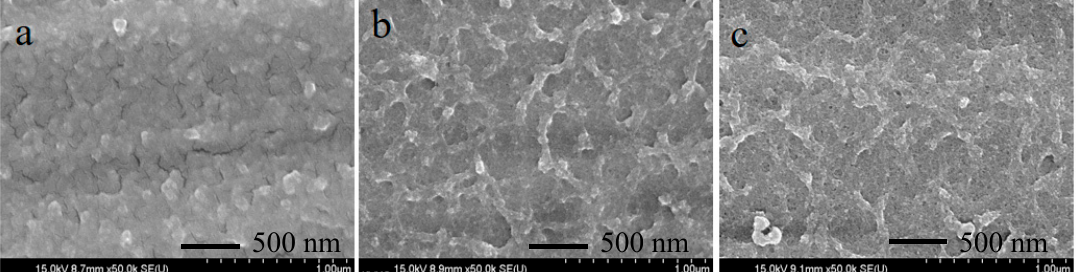
Figure 1. Typical field emission scanning electron microscope (FE-SEM) images for ( a ) NMO-9; ( b ) NMO-18; and ( c ) NMO-27 samples.